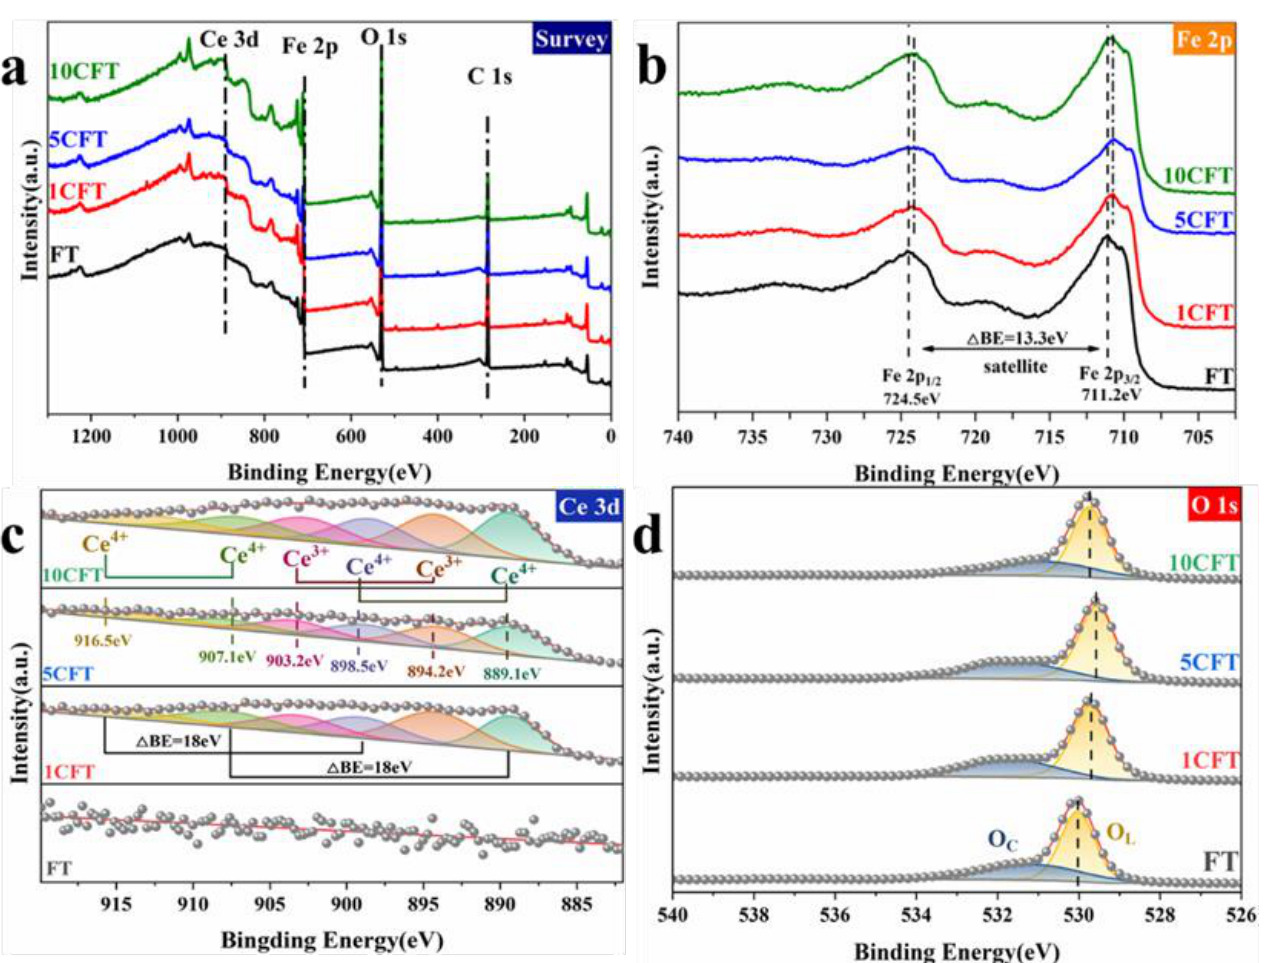
Figure 3. XPS spectra of Fe 2 O 3 (FT) and Ce-doped Fe 2 O 3 (1CFT, 5CFT, 10CFT); ( a ) the survey spectra, ( b ) Fe 2p, ( c ) Ce 3d, ( d ) O 1s.